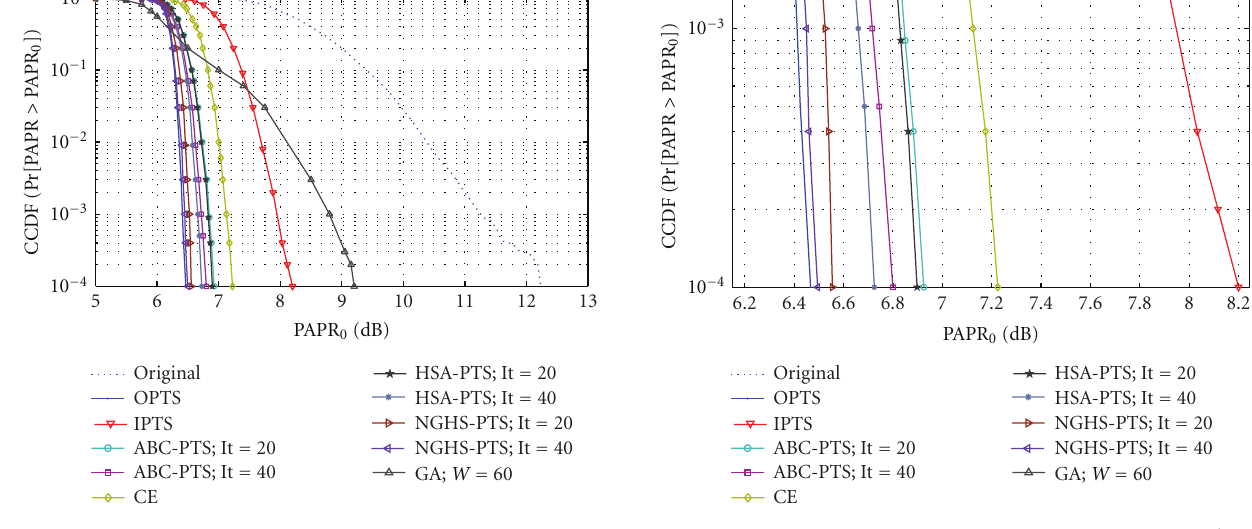
Figure 2: PAPR reduction comparison for iteration numbers 20 and 40.